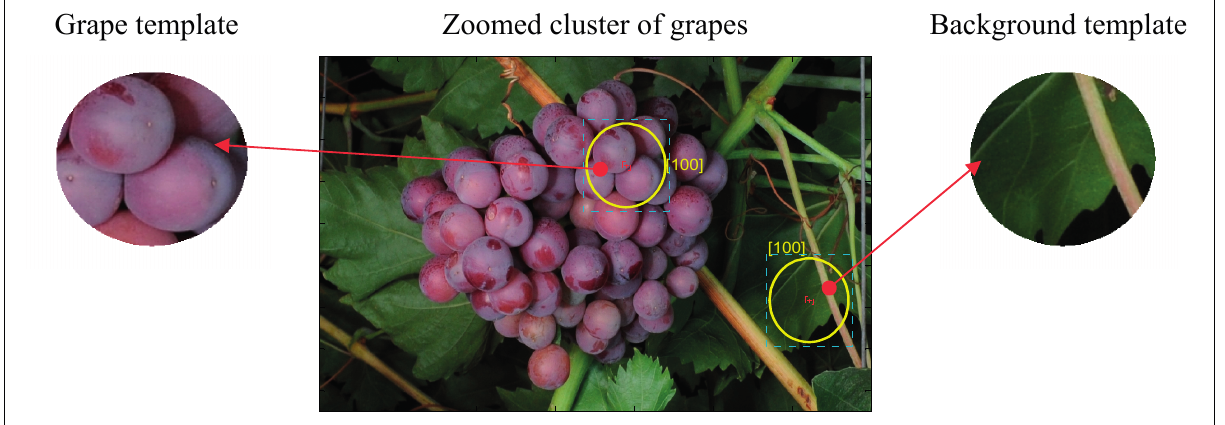
Figure 5. Example of a manual selection of the grape and background